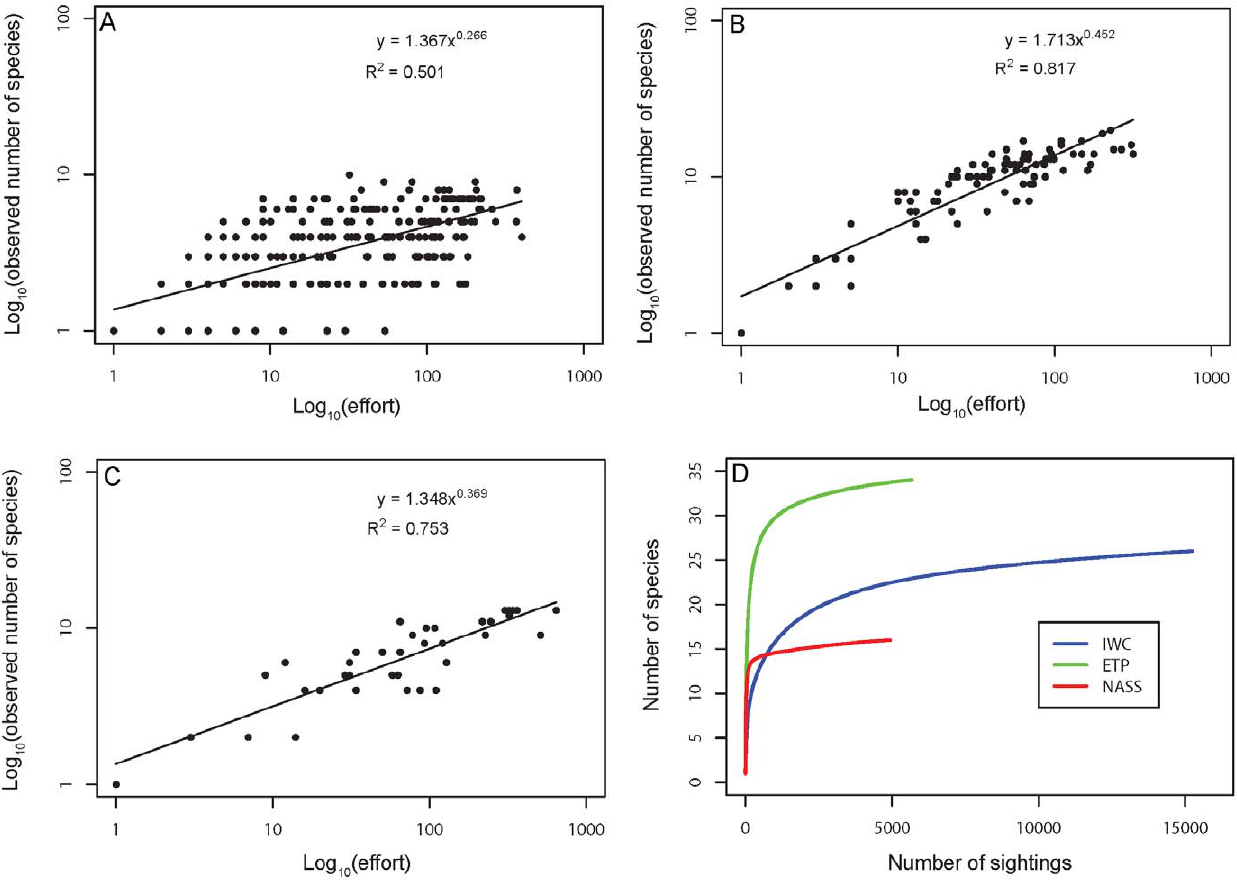
Figure 3. Rate of species discovery with survey effort. Number of species detected with increasing sampling effort in each 5 u x5 u cell in A. Antarctic waters, B. The Northeastern Atlantic, C. The Eastern Tropical Pacific, D. Species accumulation curves in different survey areas.